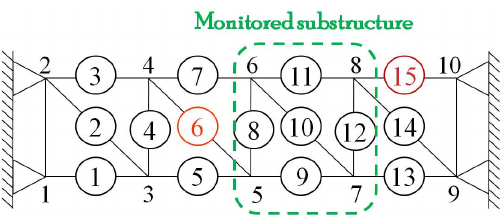
Figure 18. Experimental steel truss model with only a substructure monitored.